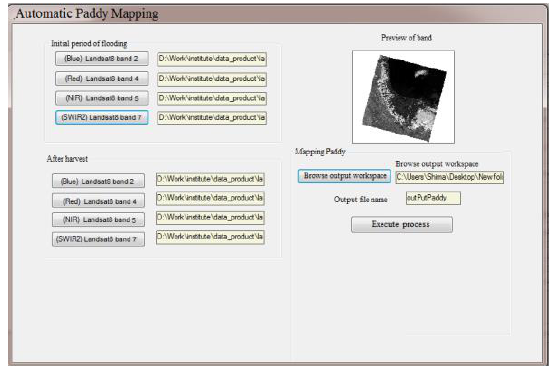
Figure 5. Paddy Mapping Interface.